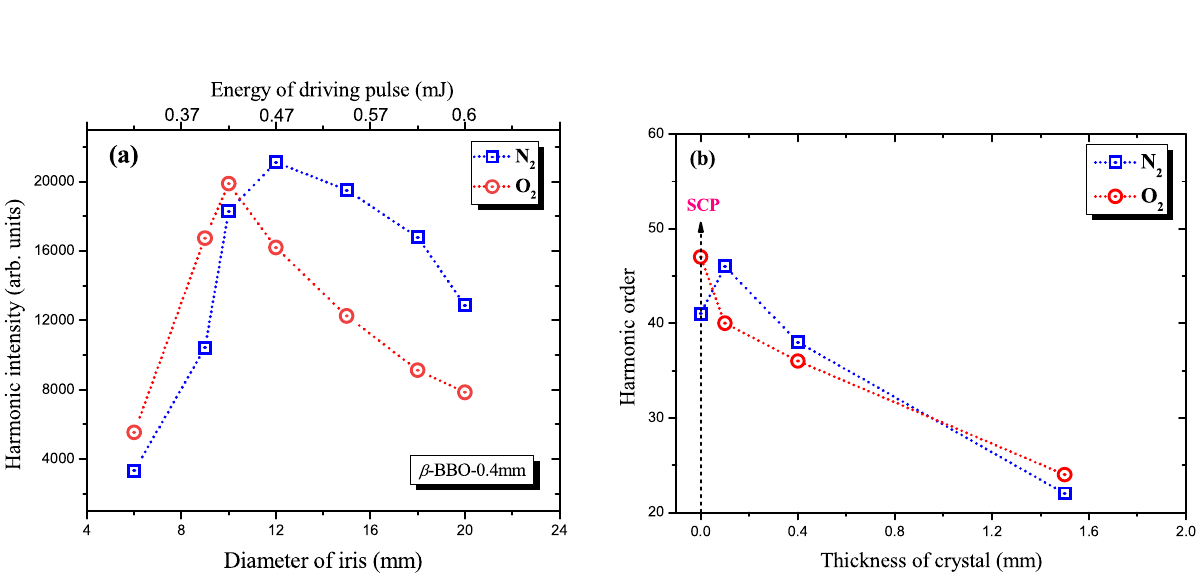
Figure 5. ( a ) Variations of 16th harmonic intensity in the case of nitrogen (empty blue squares), and oxygen (empty red circles), as a function of the iris diameter. The ratio of energy between fundamental (1030 nm) and SH (515 nm) pulses was kept at 10:1. ( b ) Dependence of the highest order harmonic on the thickness of nonlinear crystal in the case of two-color field of HHG in N 2 (empty blue squares) and O 2 (empty red circles) gases: Black dashed arrow shows the number of harmonic order for single-color